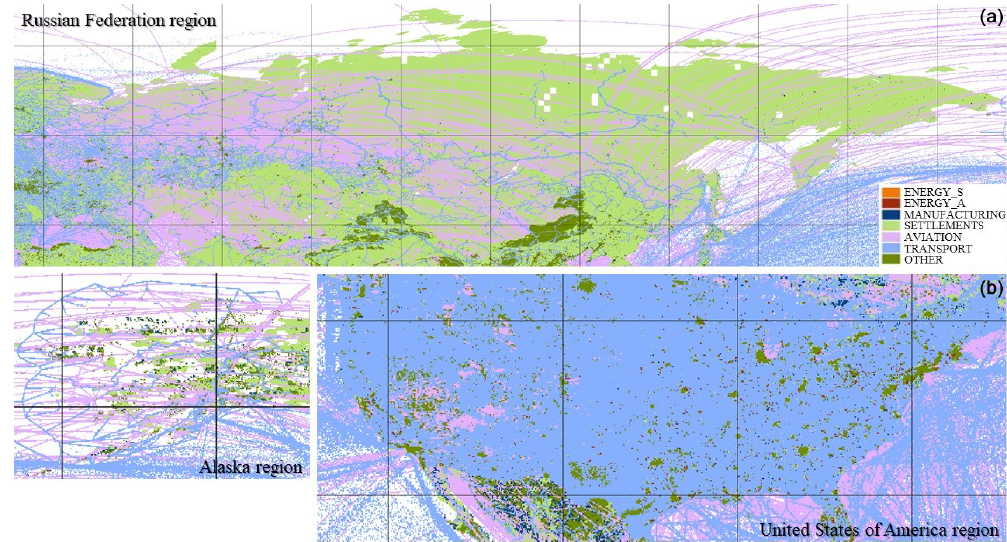
Figure 6. Main emission group that contributes to the total uncertainty per grid cell – the Russian Federation (a) and the United States of America (b) regions.